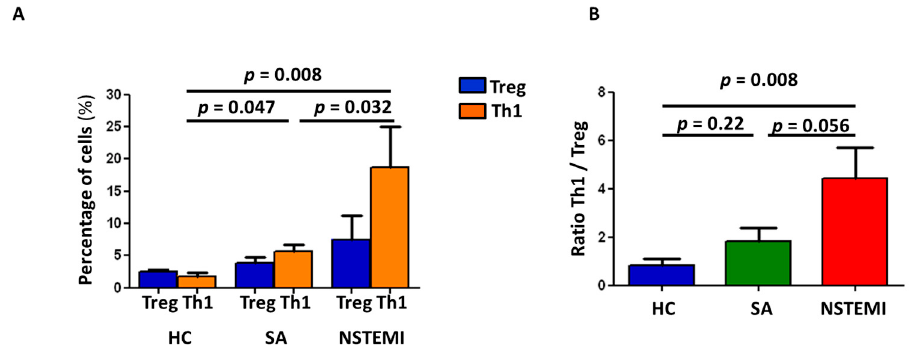
Figure 3. Mature MDDCs promote the differentiation of naïve T-cells. Naïve T-cells obtained from HC, SA and NSTEMI (5 patients for each group) were co-cultured for 6 days with autologous mMDDCs at 10:1 ratio. Afterwards, T-cell differentiation was analyzed by flow-cytometry as described in Figure S2. ( A ) NSTEMI patients showed increased Th1 differentiation compared to HC and SA ( p for trend = 0.006). No differences in absolute Treg frequency were observed among the three groups of study. ( B ) Histograms show the ratio between the percentages of differentiated Th1/Treg cells. NSTEMI and SA patients have significantly higher ratio favoring Th1 cells compared to HC, with NSTEMI having the higher ratio ( p for trend = 0.014). Data are expressed as means ±